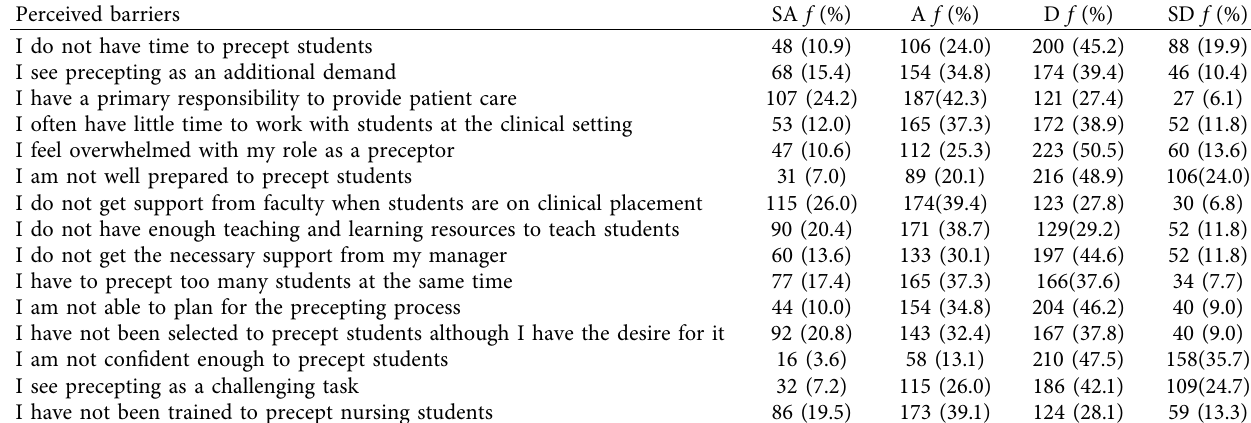
Table 4: Descriptives on the perceived barriers to successfully perform the preceptor role ( N � 442). Perceived